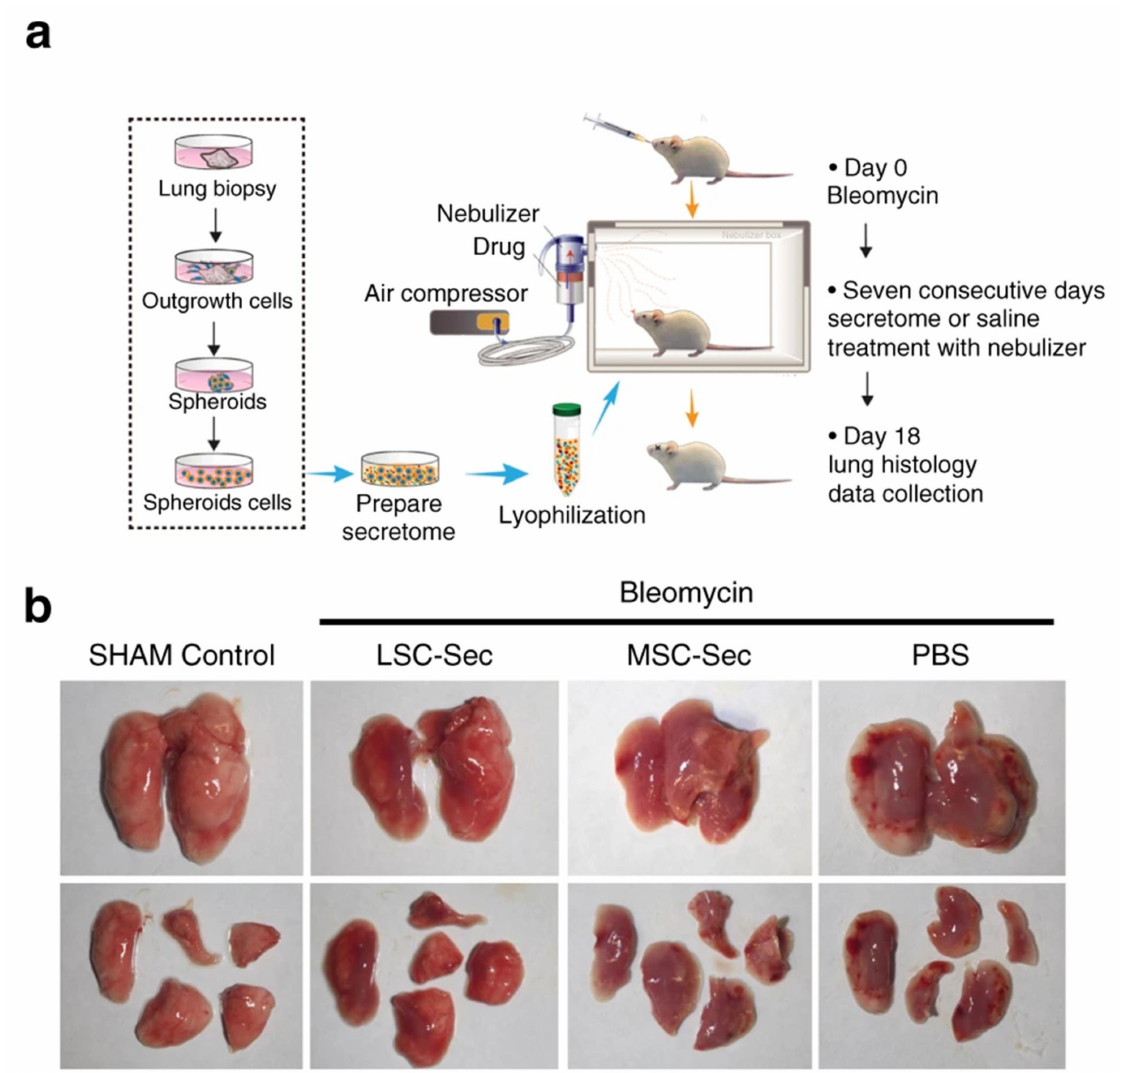
Figure 5. Administration of SC-Exos via the inhalation route. ( a ) The schematic representation of lung spheroid cell (LSC)-secretome (LSC-sec) preparation and animal model treatment with aerosolized secretome. The mice model of PF was obtained by intratracheal injection of bleomycin, and after ten days, 10 mg of secretome protein per kg of body weight was introduced to mice by a nebulizer for seven consecutive days. On day 18, animals were euthanized, and lungs were harvested for histological analysis. ( b ) Macroscopic view of harvested lungs from bleomycin-induced mice. LSC-sec and MSC-sec improved the lung condition in PF mice